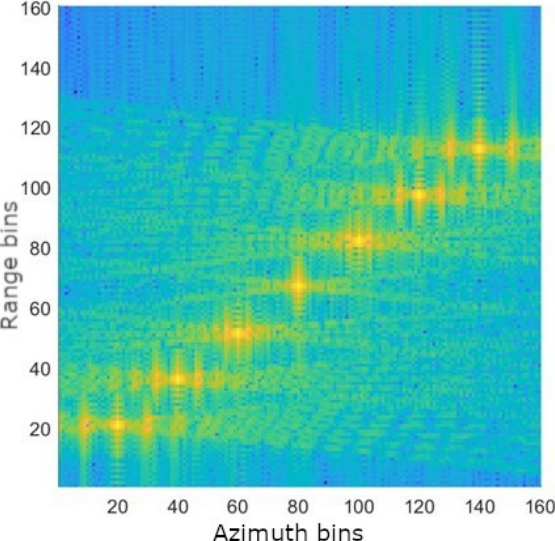
Figure 6. Simulated SAR image using SARCASTIC of seven trihedrals, each separated by 10m in azimuth and ground range from its neighbour with heights increasing by 0.5m each time from left to